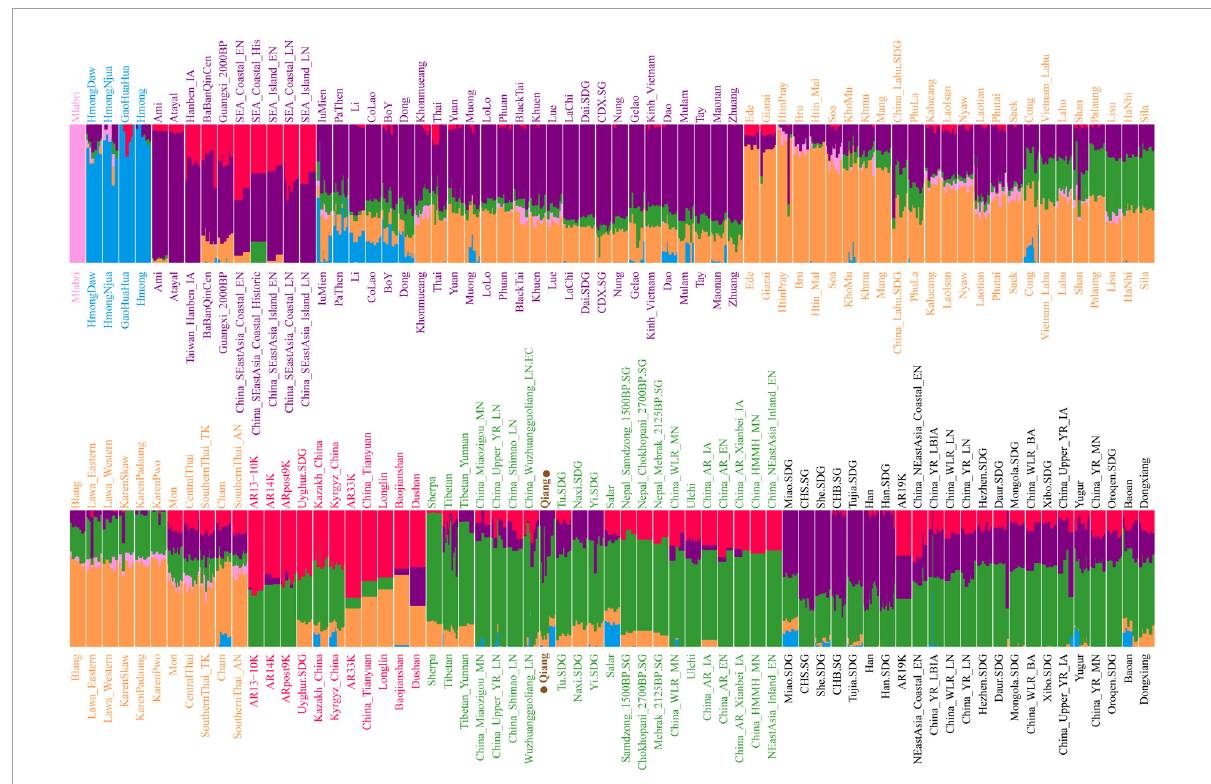
FIGURE4 Model-based ADMIXTURE results of 1,788 East Asian individuals from 133 modern and ancient populations. Each population was visualized with equal width for better presentation for the population label, which is not associated with population size. K equal to six has the least cross-validation